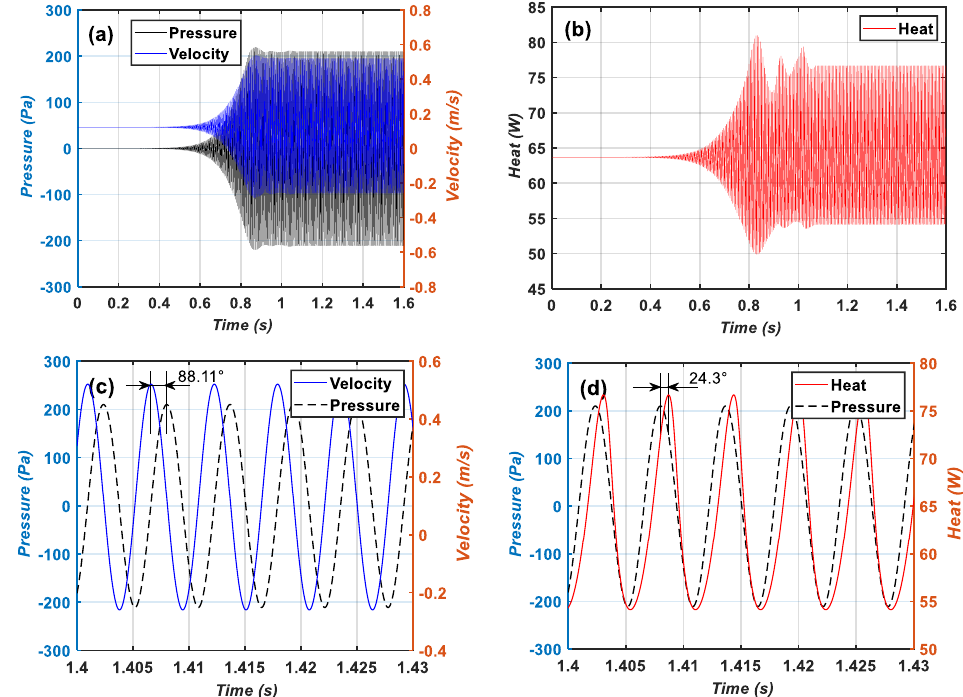
Figure 7. The time evolutions of pressure, velocity, and reaction heat release of the flame. ( a ) the time evolutions of pressure, velocity, ( b ) the time evolution of reaction heat release, ( c ) The phase relationship between velocity and pressure, and ( d ) the phase relationship between reaction heat release and pressure. Figure 7c illustrated the phase relationship between the average pressure and velocity 5 cm downstream of the flame stabilizer at the limit cycle oscillation state. It can be seen that the velocity had a 88.11° phase advance relative to the pressure.